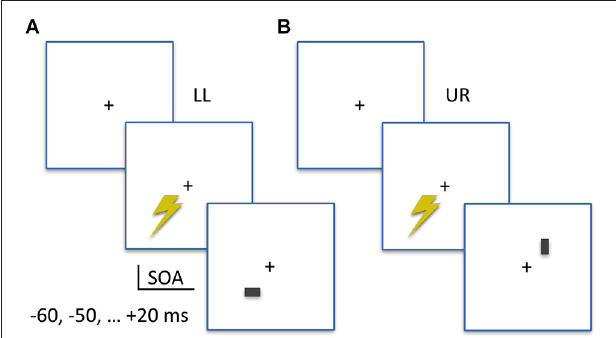
FIGURE 1 | Experimental Design . (A) Example trial of the lower-left (LL) condition. The TMS pulse is applied to LL visual field location, at an SOA prior to ( − 60, − 50, − 40, − 30, − 20, − 10 ms) or after (+20 ms) visual stimulus onset. A visual stimulus (horizontal or vertical) appears in the TMS-targeted lower-left location (LL). Participants first report the orientation of the bar, then rate the subjective visibility of the orientation. (B) Example trial of the upper-right (UR) condition. Same stimuli and SOAs as in the LL condition, but visual stimuli appear in the UR